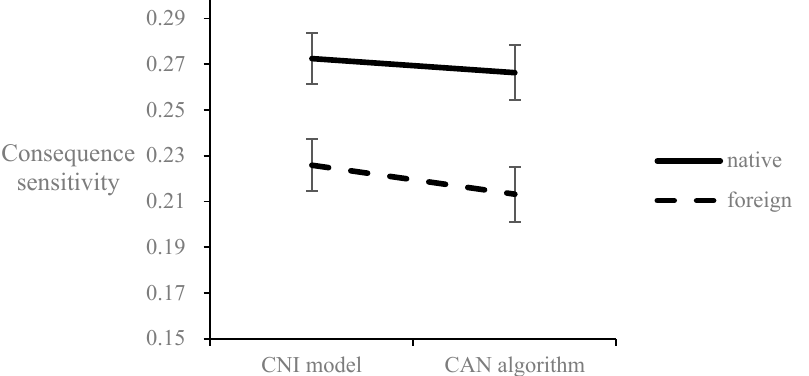
Figure 3. Consequence sensitivity estimated by the CNI model and the CAN algorithm significantly interacts with the foreign/native language condition. Error bar represents the ±1 standard error.